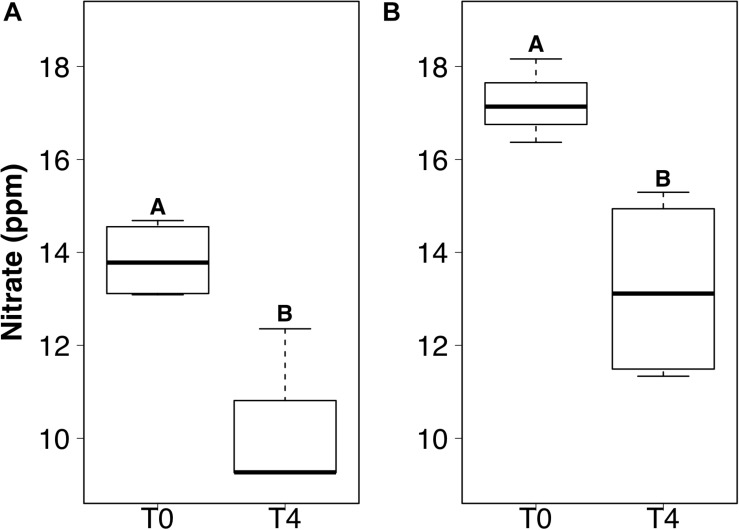
Boxplots showing the median, upper, and lower interquartile range of nitrate concentrations for DIN treatment (A) and combined dissolved inorganic phosphorus (DIP) and DIN treatment (B) at the initial (T0) and final (T4) time points. Uppercase letters denote homogeneous subsets derived from post hoc Tukey HSD analysis on a significant two-way ANOVA in relation to the time point and treatment.